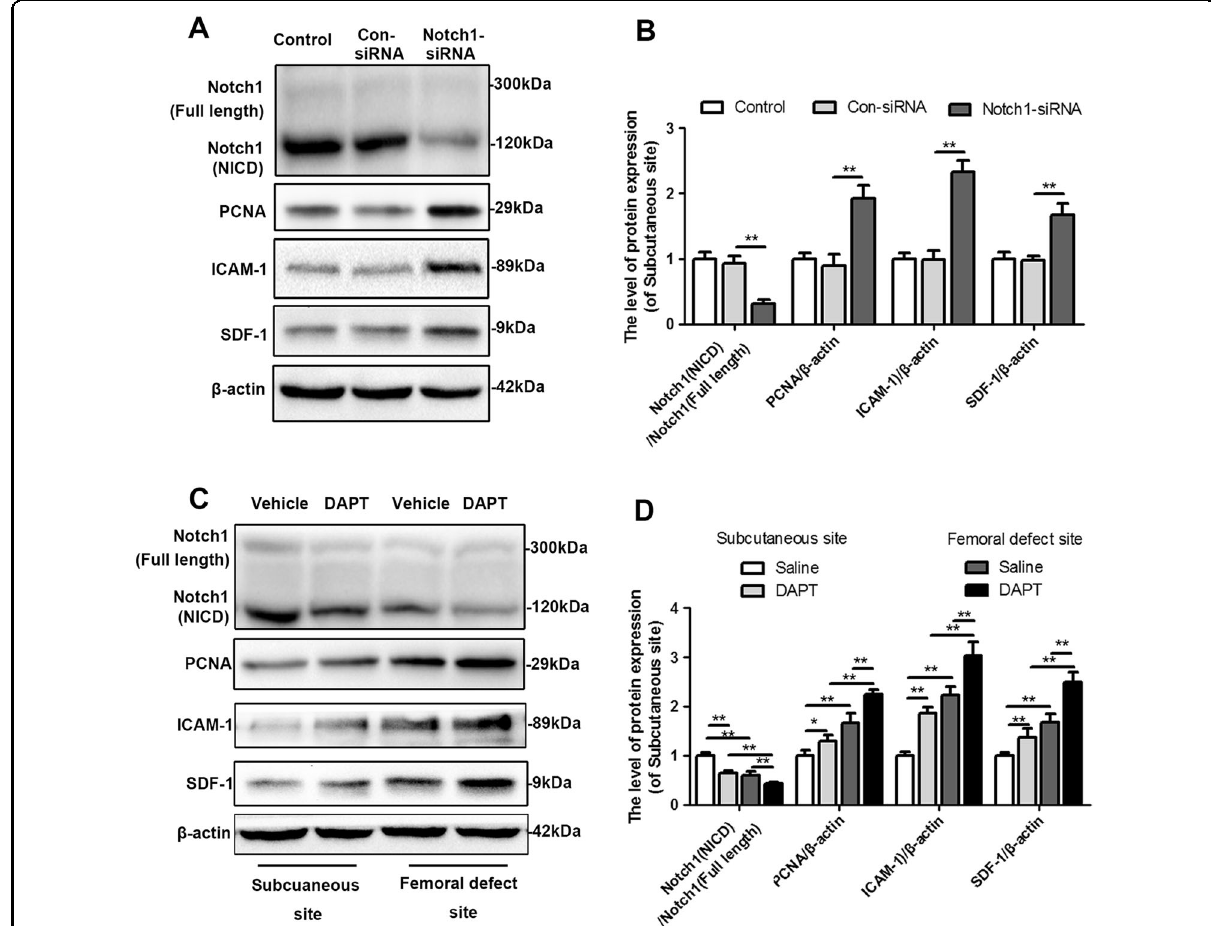
Fig. 7 Inhibition of Notch1 promotes proliferation, migration and recruitment of EPCs. a – b The protein expression and quantitative data for Notch1, PCNA, ICAM-1 and SDF-1 in EPCs treated with control-siRNA or Notch1-siRNA. c – d The protein expression and quantitative data for Notch1, PCNA, ICAM-1 and SDF-1 in EPCs treated with the protein extracted from the induced membrane derived from the subcutaneous site and femoral defect site with or without DAPT intervention. The data in the fi gures represent averages ± S.D. Signi fi cant differences between the different groups are indicated as * P < 0.05, ** P < 0.01; for each group, n =